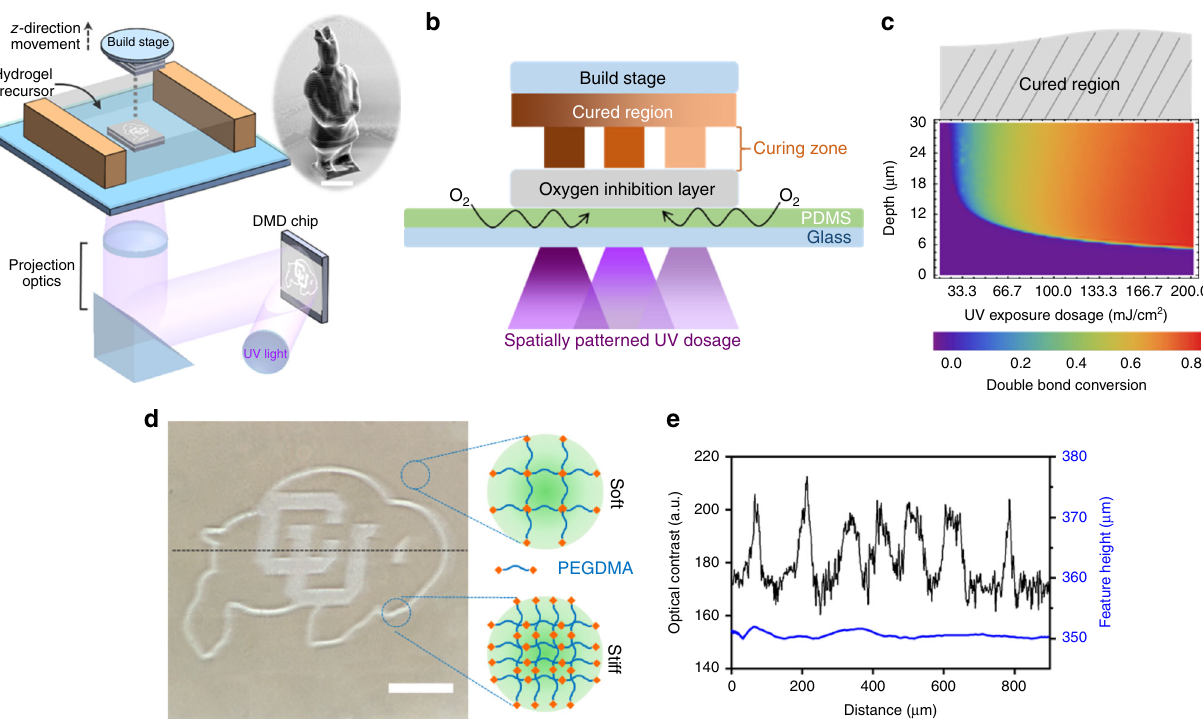
Fig. 1 Orthogonal programming of matrix stiffness and geometry via oxygen inhibition-assisted stereolithography. a Schematic set-up of digital projection stereolithographic 3D printing system where hydrogel precursor solution is cured layer-by-layer through UV exposure. Inset is a SEM image of a 3D- printed complex object. Scale bar is 500 μ m. b Schematic of oxygen inhibition-assisted printing, in which the curing zone is physically limited between the cured region and the oxygen inhibition layer. c Depth pro fi le of double bond conversion rate under different UV exposure dosages. The thickness of oxygen inhibition layer is weakly dependent to the exposure dosages, and so does the curing thickness. The double bond conversion rate rapidly increases with the dosage when dosage is above the threshold. d Bright- fi eld optical image of a printed buffalo logo with independently patterned stiffness and geometry (binary stiffness but fl at surface). High optical contrast indicates the strong differences in crosslink density and, therefore, the stiffness. Scale bar is 200 μ m. e Quanti fi cation of optical contrast (black line) and geometry (blue line) variation along the dotted line in b reveals sharp differences in contrast (stiffness) but little feature height variation ( <